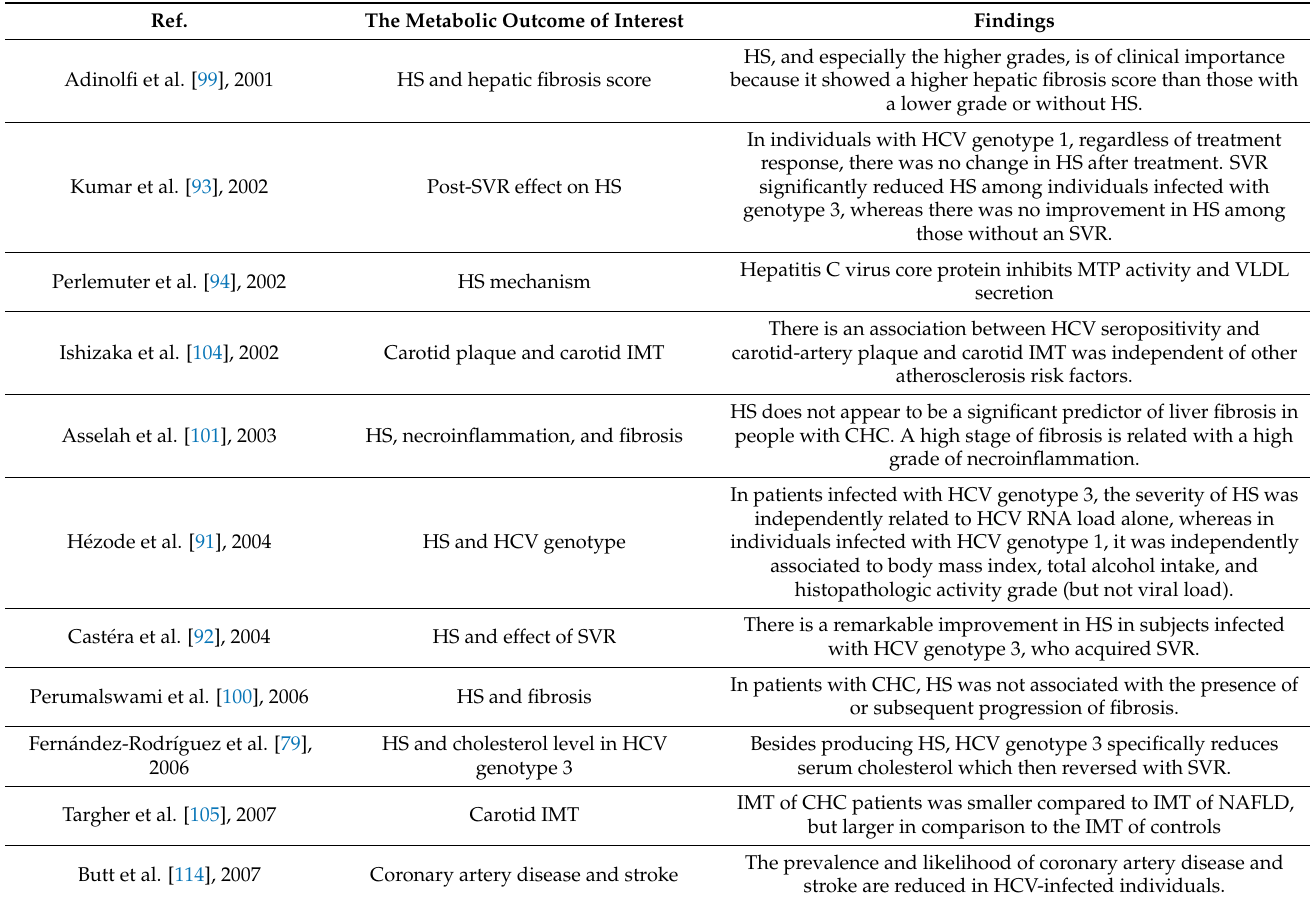
Table 1. Summary of studies investigating metabolic manifestations of chronic hepatitis